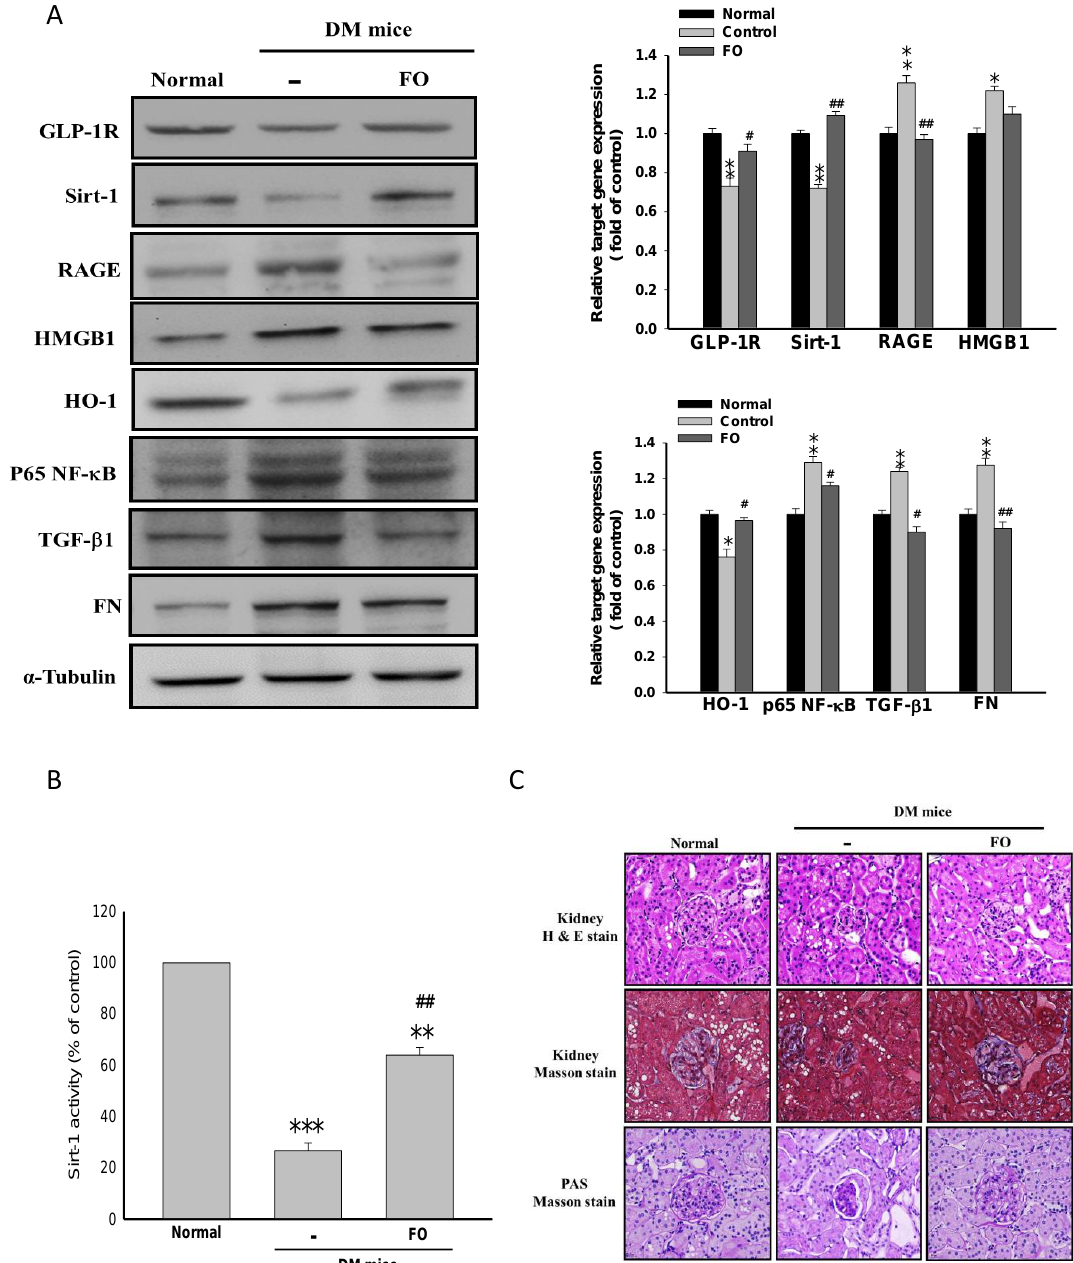
Figure 5. The e ff ects of fucoidan on fibrosis-related gene expression, Sirt-1 activity, and the histological changes in the kidney of diabetic nephropathy mice. The expression of target genes ( A ), the Sirt-1 activity ( B ), and the histological changes evaluated by Masson staining and PAS staning ( C ) in the kidney of the diabetic mice were examined in di ff erent groups. Results were expressed as the mean ± SEM ( n = 8). * p < 0.05, ** p < 0.01, *** p < 0.001 vs. normal mice; # p < 0.05, ## p < 0.01 vs. untreated diabetic nephropathy